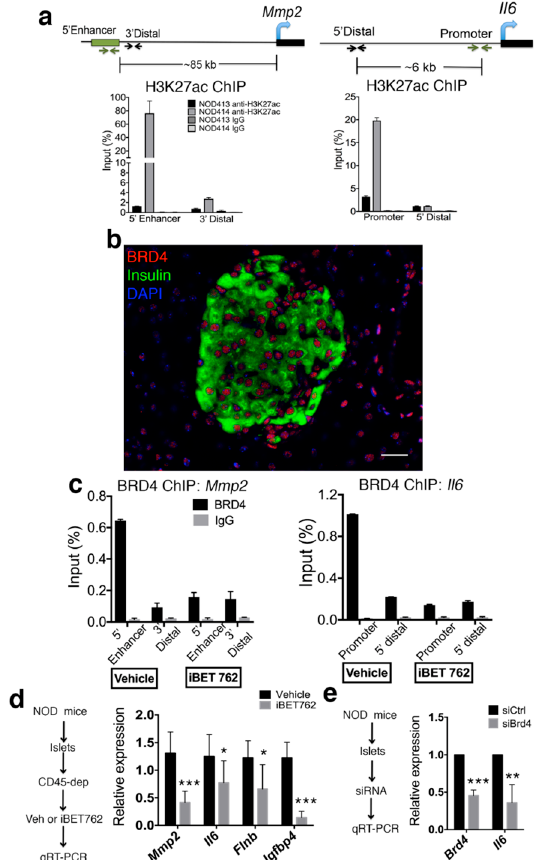
Figure 1. BET protein BRD4 is required for transcriptional activation of senescence-associated secretory phenotype (SASP) genes in nonobese diabetic (NOD) islets. ( a ) Chromatin immunoprecipitation and quantitative polymerase chain reaction (ChIP and qPCR) for H3K27ac at the enhancer of Mmp2 and promoter of Il6 , along with distal negative regions, on islets isolated from two different euglycemic 14-week-old NOD mice (NOD413, NOD414), n = 2 biological replicates per mouse. Female mice are used throughout our study. The schematic shows the positions of the regions in the ChIP. Immunoglobulin G (IgG) ChIP was a negative control. Error bars are SD. ( b ) Representative IHC for BRD4 and insulin with DAPI on pancreas section from euglycemic NOD mice at eight weeks of age. Scale bar = 20 μ m. ( c ) ChIP and qPCR for BRD4 at the same regulatory regions of Mmp2 and Il6 shown in ( a ) on pooled islets from euglycemic 14-week-old NOD mice cultured for 18 h with vehicle or iBET-762 ( n = 2 biological replicates per group), error bars are SD. IgG ChIP was a negative control. ( d ) Islets isolated from 14-week-old NOD mice were depleted of CD45 + immune cells to enrich for endocrine islet cells and then cultured for 24 h with vehicle (Dimethyl Sulfoxide, DMSO) or iBET-762 followed by quantitative reverse transcription polymerase chain reaction (qRT-PCR) analysis. qRT-PCR of SASP genes Mmp2 , Il6 , Flnb, and Igfbp4 show the average relative expression for vehicle ( n = 5 biological replicates) or iBET-762 treated ( n = 4 biological replicates) islets cells. Error bars are SD. ( e ) qRT-PCR for Brd4 and Il6 on 14-week-old NOD islets transfected with non-targeting control or Brd4 siRNAs. Data show average expression levels in siBrd4 relative to siCtrl from n = 3 independent experiments. Error bars are SD. For all panels, * p < 0.05, ** p < 0.005, *** p < 0.0005, two-tailed t-tests.